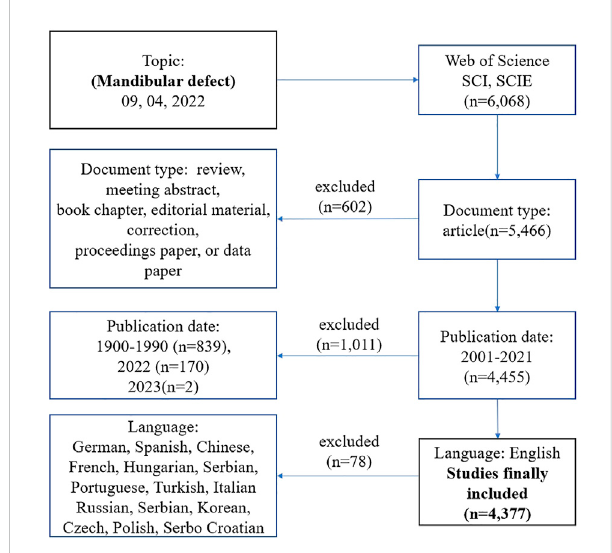
FIGURE 1 Frame fl ow diagram of mandibular defect search strategy from 2001 to 2021 based on Web of